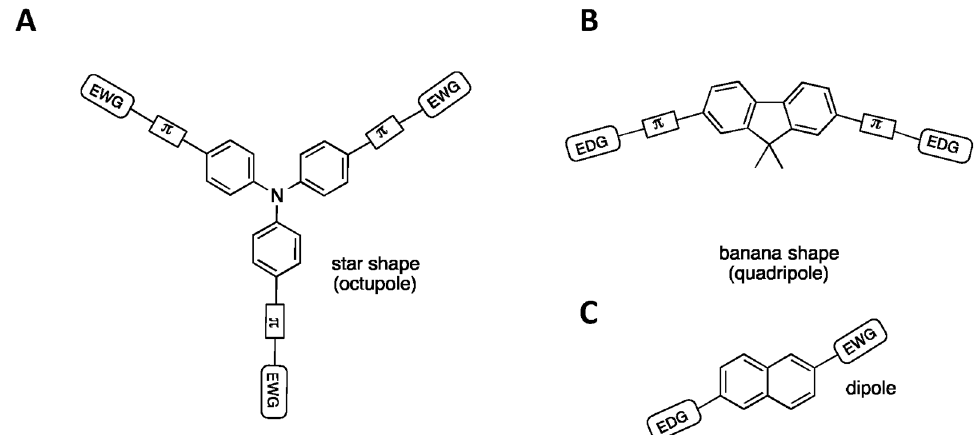
Figure 6. Preferred structures for two-photon absorption. ( A ) Star shape or octupole; ( B ) Banana shape or quadripole; ( C ) Dipole. EWG, Electron-Withdrawing Group; EDG, Electron-Donating Group; π , conjugated π system.